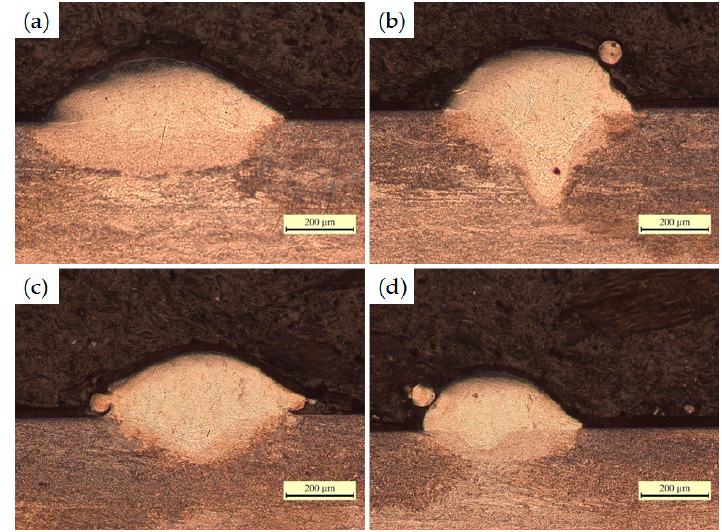
Figure 5. OM micrographs exposed on the cross section of single scan tracks as the scanning speed increased ( P = 400 W, δ = 200 μ m). ( a ) v = 80 mm/s; ( b ) v = 120 mm/s; ( c ) v = 160 mm/s; ( d ) v = 200 mm/s.